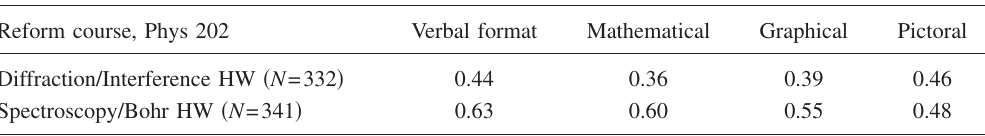
TABLE II. Fraction of students answering a homework problem correctly, sorted by representational format and topic. Standard errors of the mean vary but are on the order of 0.02.